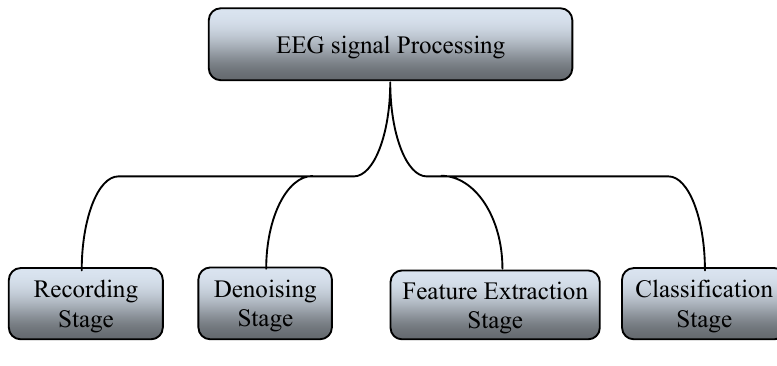
Figure 4. The main stages that use to process EEG signal.